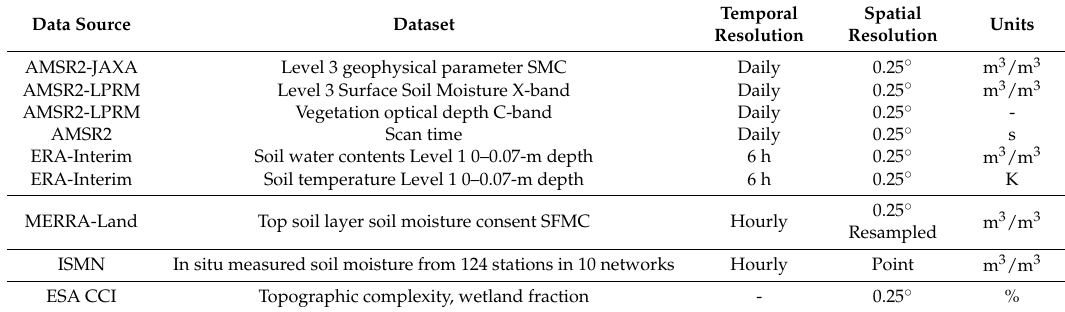
Table 1. Details of datasets used in this